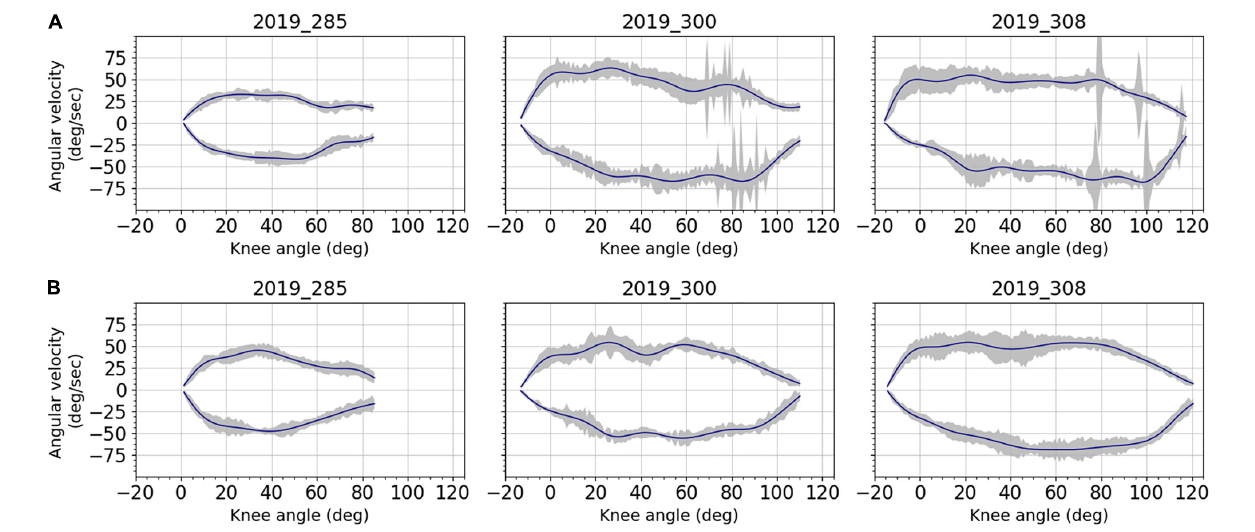
FIGURE 3 | Averaged angular velocities and corresponding standard deviations (gray area) over the knee angles for all subjects: (A) anterior fascia; (B) lateral fascia and ITT. Data were filtered using a forward-backward linear filter. Filter coefficients were obtained from a low-pass digital Butterworth filter (3rd order, cut off frequency of 2Hz) that was first applied on data. Even though angular velocity was applied manually, results show good reproducibility for each subject. Inter-subject variability can be observed because of subjects’ different knee mobility and associated range of